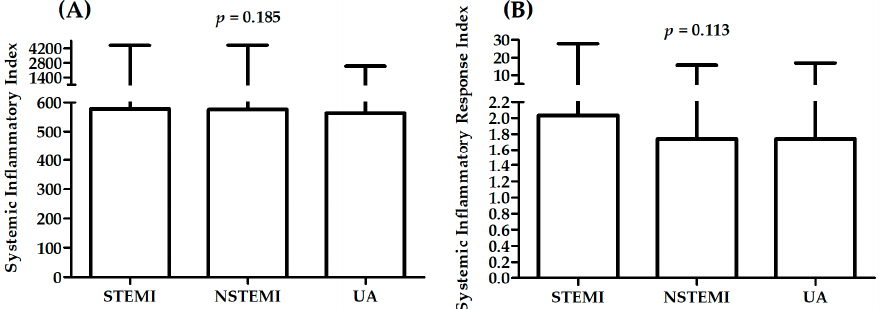
Figure 4. Differences in SII ( A ) and SIRI ( B ) between patients with STEMI, NSTEMI and UA.